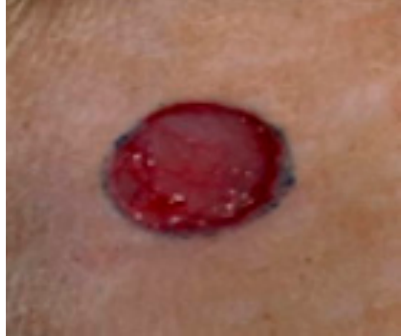
Figure 9. Image of a wounded area of diabetic rats on the 0th day.